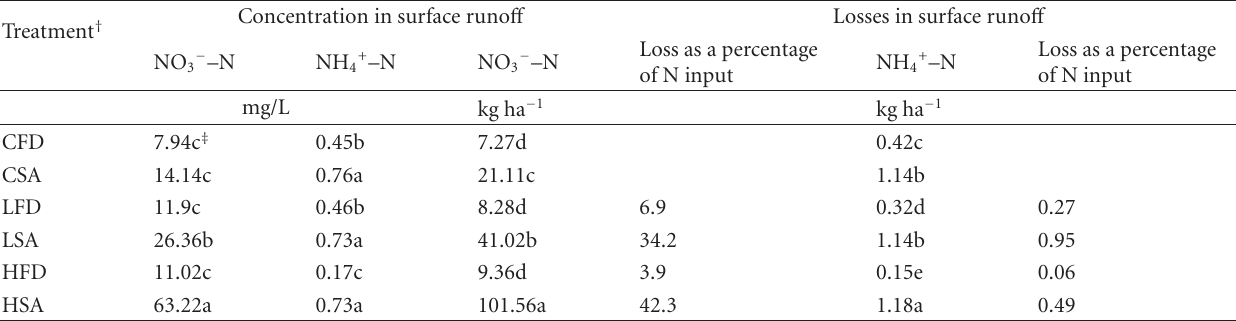
Table 2: Means of nutrient concentration with runo ff under di ff erent near-surface soil moisture conditions. Concentration in surface runo Treatment †